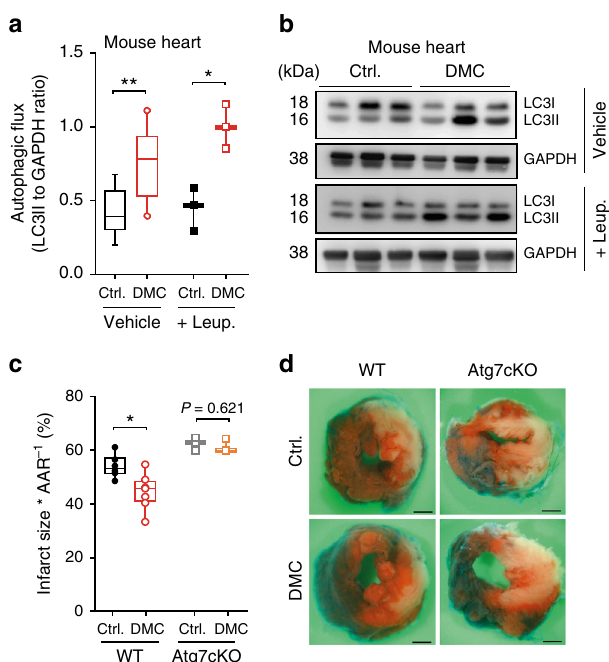
Fig. 3 4,4 ′ -dimethoxychalcone promotes autophagy and cardioprotection in mice. a , b Autophagy induction in mouse heart tissue ( a ) determined by LC3 lipidation with leupeptin or vehicle injection after intraperitoneal injection of DMC (100 mg/kg) or DMSO (Ctrl.). n = 9 (Ctrl. Vehicle), 10 (DMC Vehicle), 3 (Leup.) animals, * P = 0.0105, ** P = 0.0028; b representative immunoblot. c , d Infarction area per area at risk (AAR) ( c ) and representative images of left ventricular myocardial sections (scale bar: 1 mm) ( d ) after DMC treatment as in ( a – b ) followed by 3 h prolonged ischaemia in wild type (WT) and cardiac-speci fi c Atg7 knockout mice (Atg7cKO). * P = 0.0134, n = 5 (Ctrl.), 6 (DMC), 3 (Atg7cKO) animals. Signi fi cance in ( a , c ) was assessed by two-sided Student ’ s t -tests between Ctrl. and DMC. Box plots represent IQR (line at median) and whiskers 10 – 90 percentile. Source data for ( a , c ) are provided as a